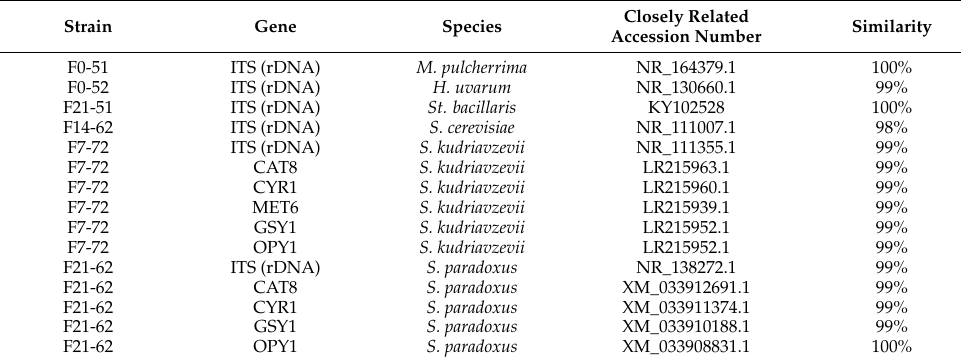
Table 3. Results of sequencing